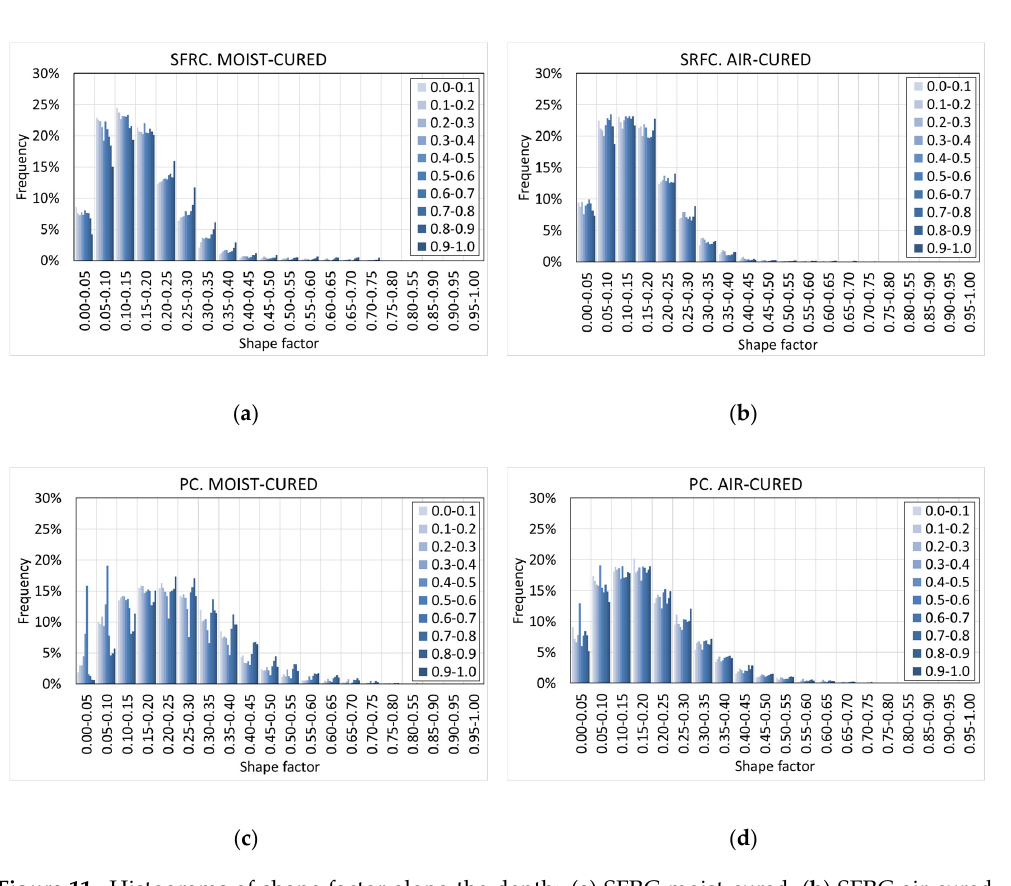
Figure 11. Histograms of shape factor along the depth: ( a ) SFRC moist-cured, ( b ) SFRC air-cured, ( c ) PC moist-cured and ( d ) PC air-cured.